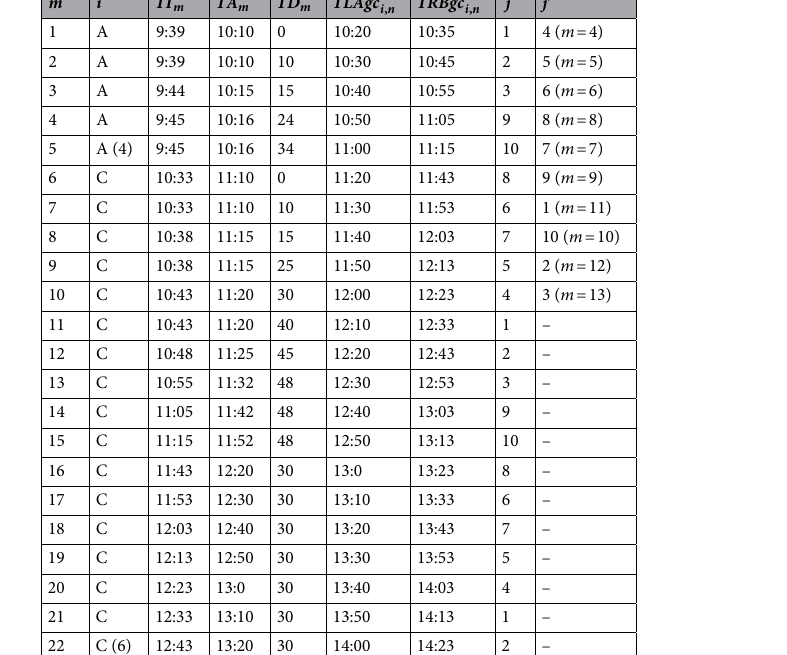
Table 4. The calculation results after order adjustment.